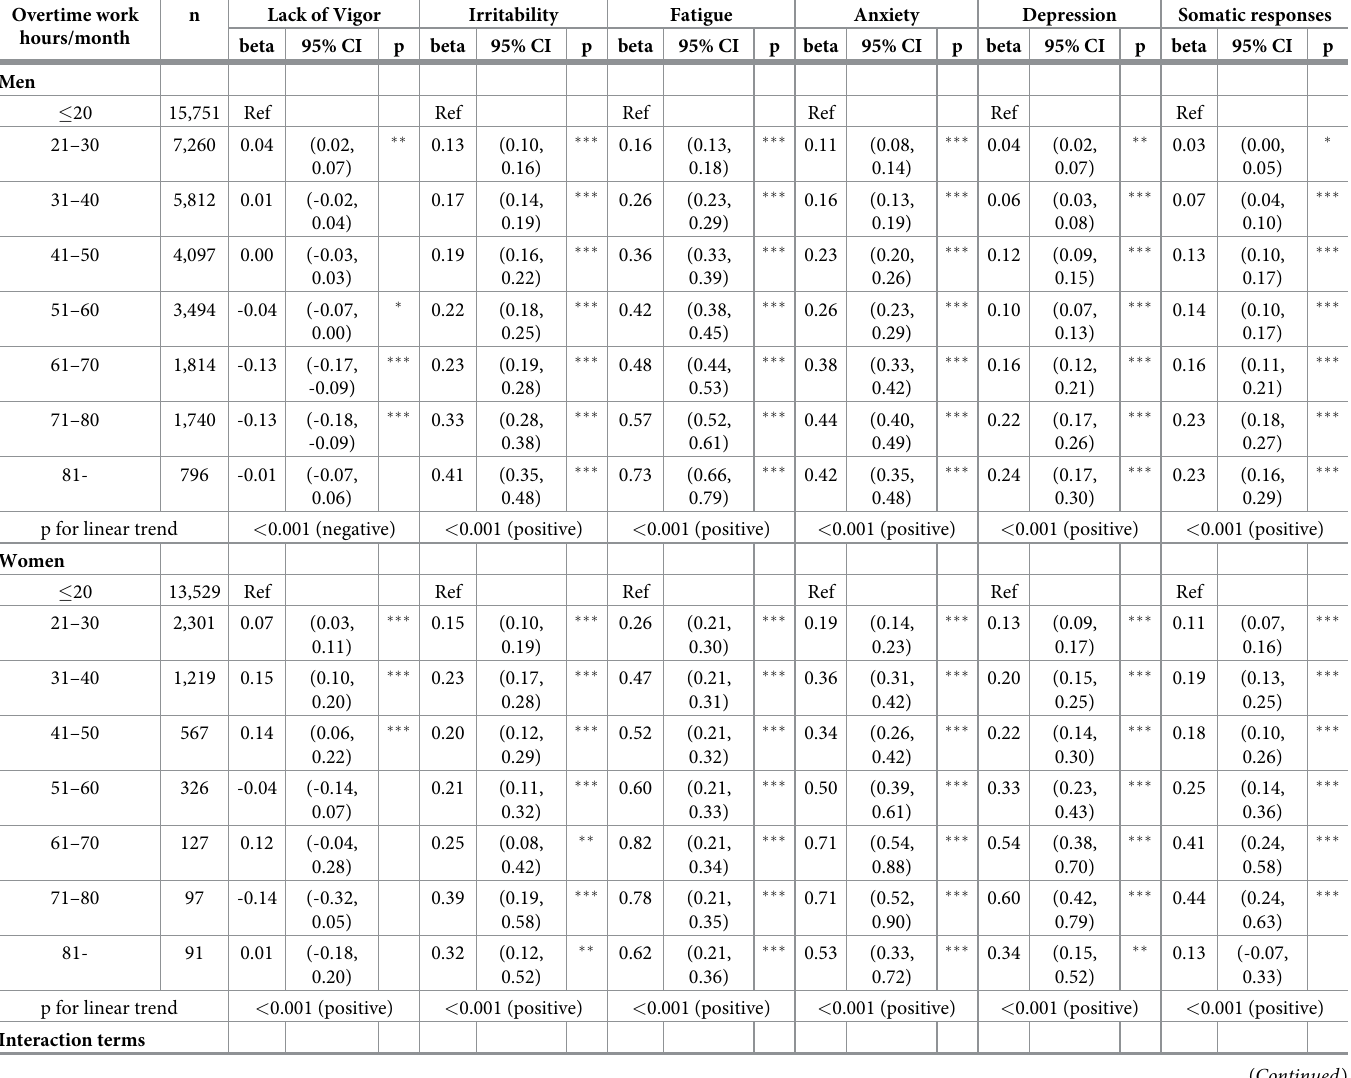
Table 2. Associations between overtime work hours and stress responses: Gender-stratified multiple linear regression